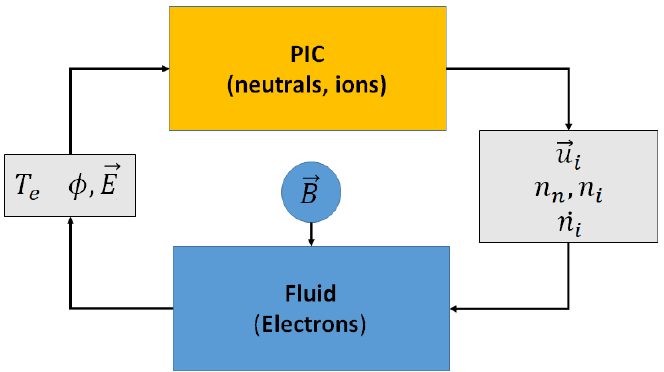
Figure 2. HYPICFLU: variables exchange between fluid and PIC